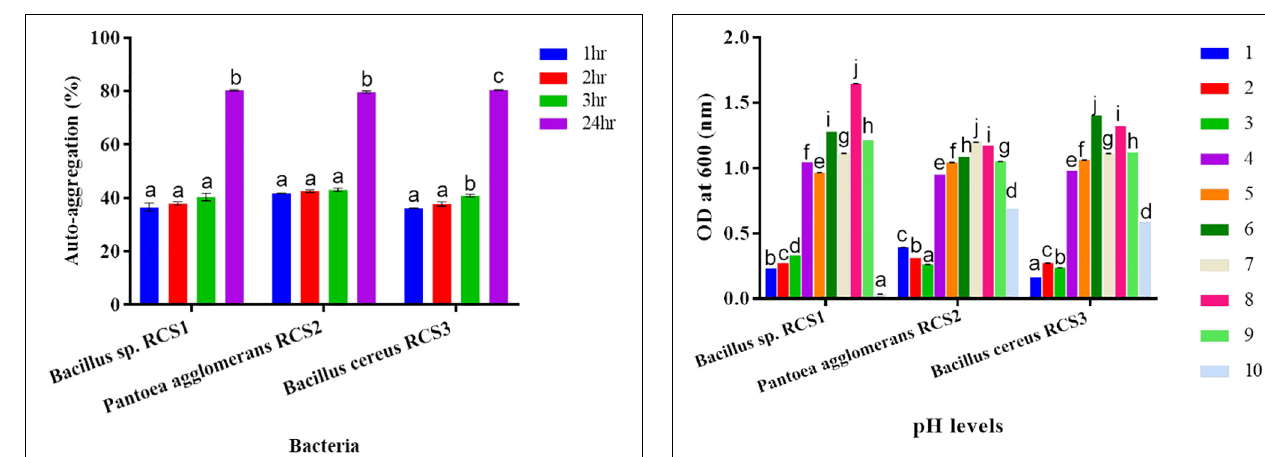
FIGURE 5 | Auto-aggregation of bacteria after 24 h. Values are presented as mean ± SE. Different letters show significant differences ( P < 0.05).